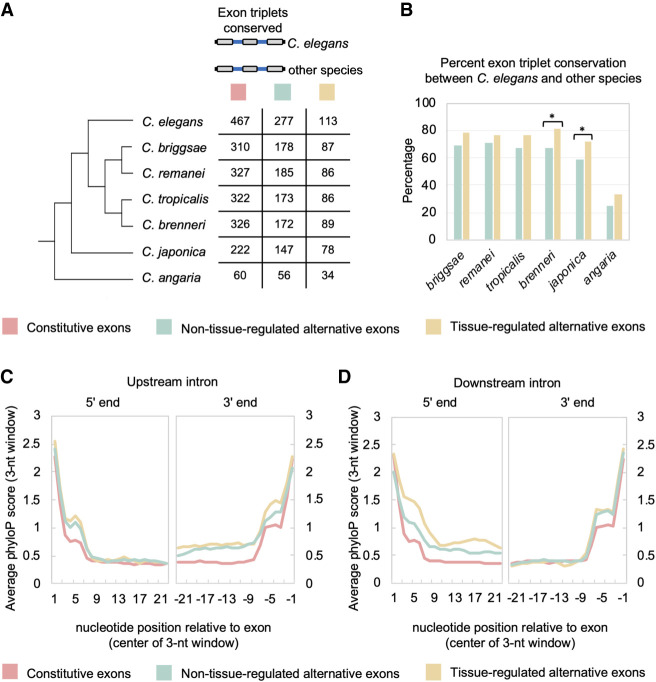
Alternative and tissue-regulated splicing are associated with increased conservation patterns. (A, left) Phylogenetic tree of Caenorhabditis species used in alignments. (Right) Splicing events were separated into three classes of exon triplets: constitutive exons, non-tissue-regulated alternative exons, and tissue-regulated alternative exons. Table shows number of exon triplets in each group and their conservation across the phylogeny. (B) Graph of percentage of conserved exon triplets for non-tissue-differential alternative exons (light blue bars) and tissue-differential alternative exons (gold bars) between C. elegans and other Caenorhabditis species of varying divergence. (*) P-value < 0.02, Fisher's exact test. (C) Plot of average phyloP score (rolling 3-nt average) over first 23 nt (left) and last 23 nt (right) of the upstream intron flanking the internal exon of the exon triplets described in panel A. (D) Same as in C, but plots of the average phyloP score for the downstream intronic regions.